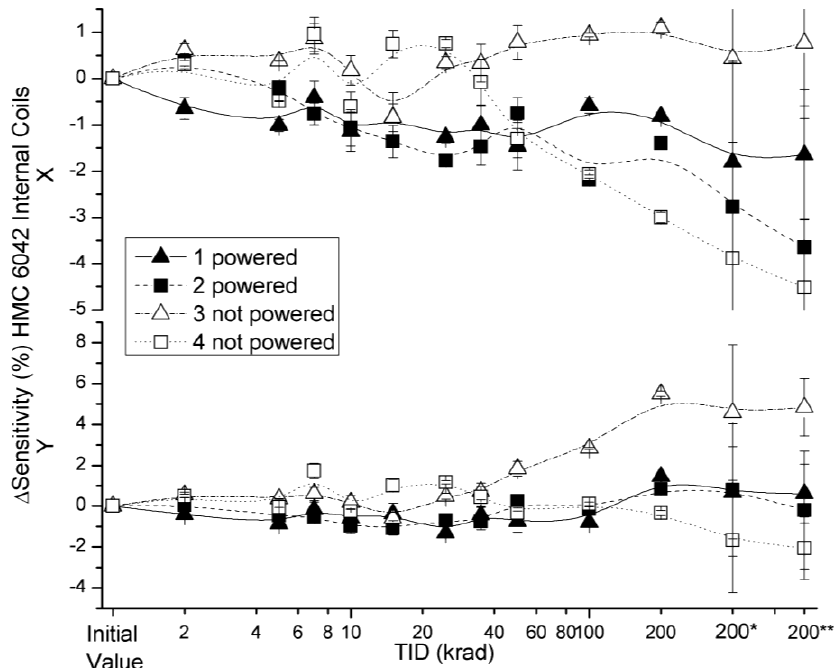
Figure 10. Sensitivity deviation measured for internal coil configuration as a function of TID for powered and non-powered HMC